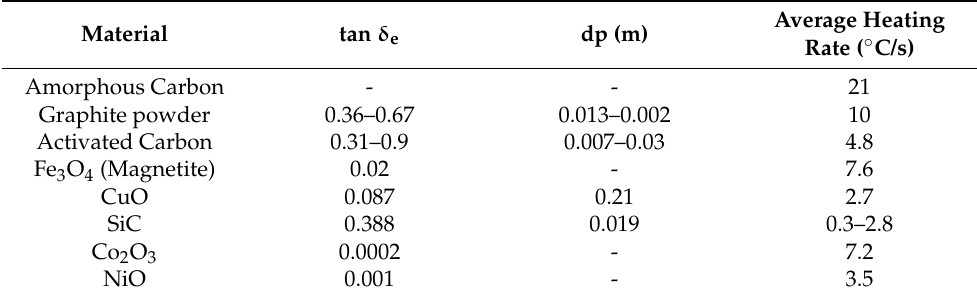
Table 1. Microwave dielectric properties (tan δ e and dp) and average heating rate of selected susceptor materials. The values are from the references [76,79–81].